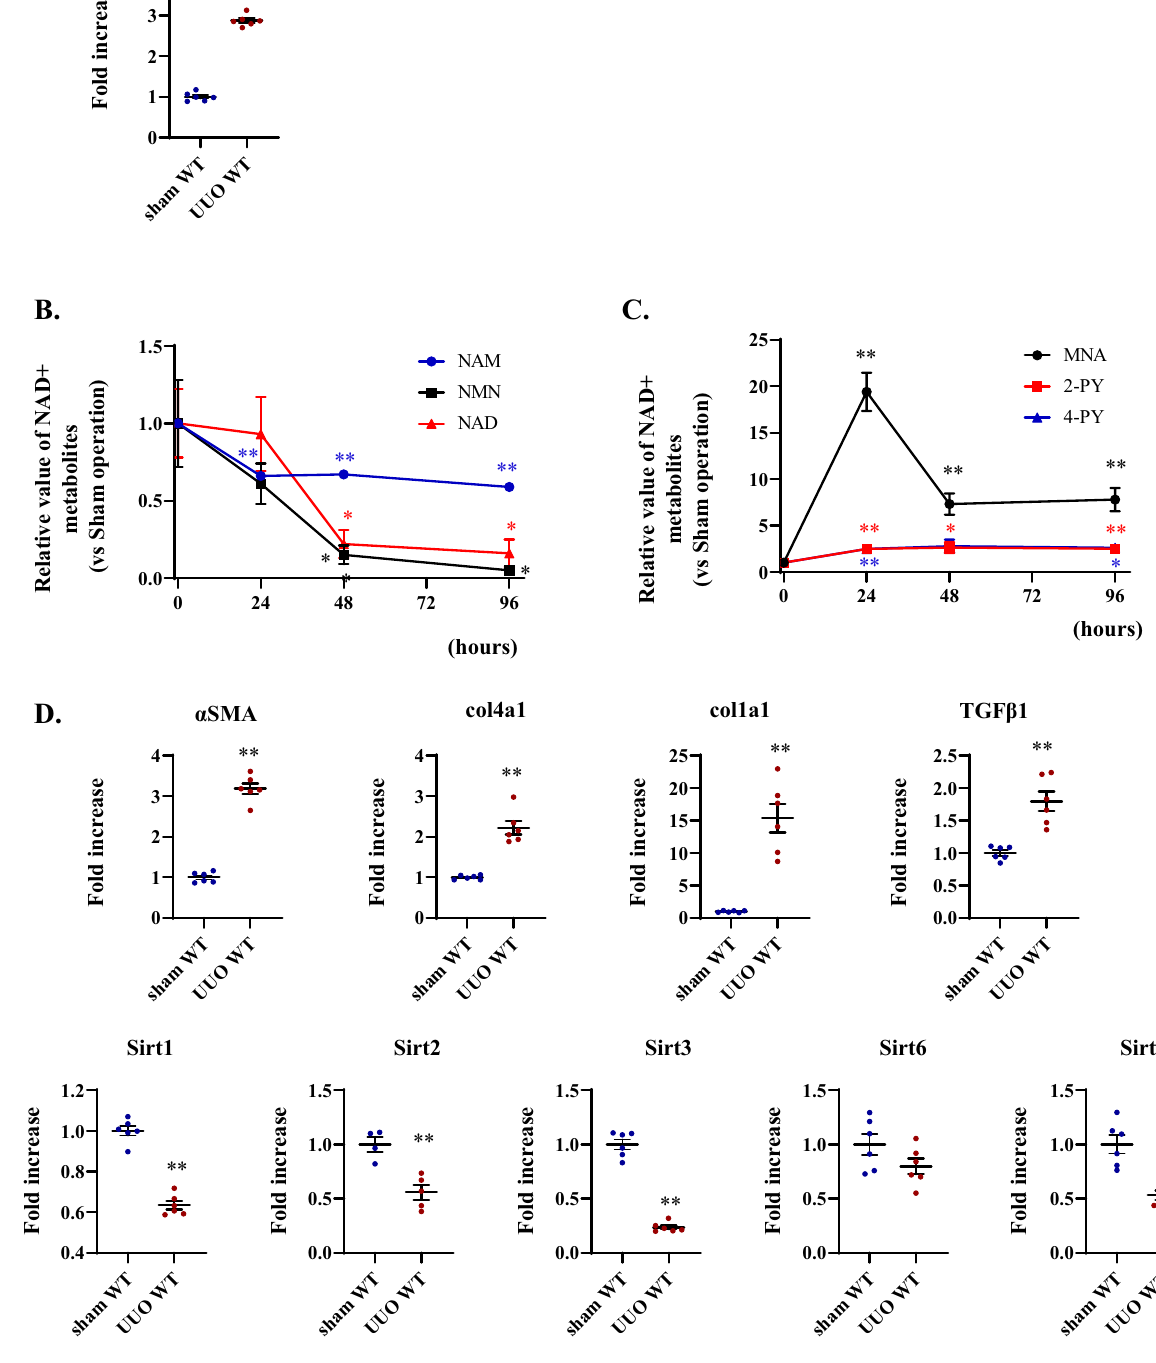
Figure 2. Increased renal NNMT expression and NNMT-mediated NAD + metabolite fluctuations in unilateral ureteral obstruction (UUO) models. ( A ) Renal NNMT expression after four days UUO. The values shown are means ± SEM ( n = 6 per group). ( B ), ( C ) Time course of renal NAD + metabolite changes after UUO induction. The values shown are means ± SEM ( n = 3–4 per group). ( D ) mRNA expressions of fibrosis- related genes and sirtuins after four days UUO. The values shown are means ± SEM ( n = 4–6 per group). UUO, unilateral ureter obstruction; NNMT, nicotinamide N-methyltransferase; NAD + , nicotinamide adenine dinucleotide; NAM, nicotinamide; NMN, nicotinamide mononucleotide; NNO, nicotinamide-N-oxide; MNA, 1-methylnicotinamide; N-Me-2PY, N-methyl-2-pyridone-5-carboxamide; N-Me-4PY, N-methyl-4-pyridone- 3-carboxamide; αSMA, α-smooth muscle cell actin; col, collagen; TGF, transforming growth factor. * P < 0.05, ** P < 0.01 versus control (sham-operated